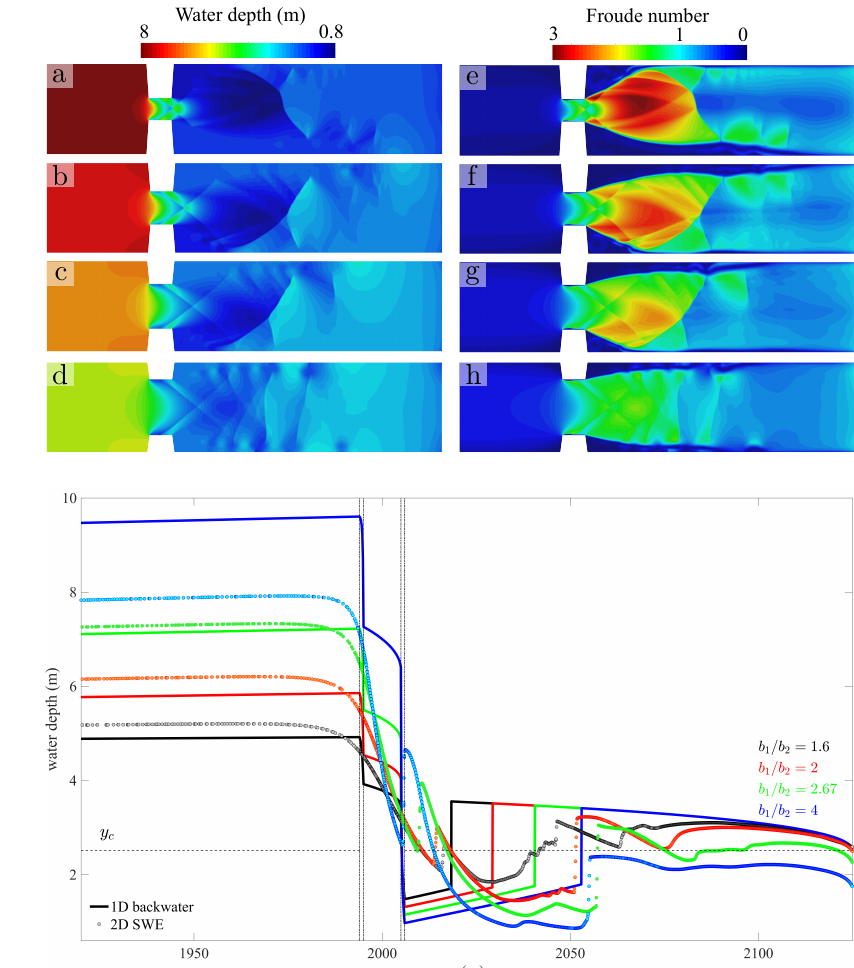
Figure 19. Flow patterns at abrupt contractions and large width ratios, b 1 / b 2 . We show maps of water depth (panels a – d ) and Froude number (panels e – h ) for different width ratios, leading to increasing effective Froude numbers in the supercritical flow region. We increase the Froude number downstream of the contraction by keeping the basic flow conditions of Figures 3, 16 and 17, in particular b 1 = 40 m, and considering an abrupt contraction, L e = 1 m, while reducing the width of the narrowest segment, b 2 . The width ratios are b 1 / b 2 = 4 (panels a and e ), 2.67 (panels b and f ), 2 (panels c and g ), and 1.6 (panels d and h ). We compare the 1D and 2D predictions of the water surface profile (panel i ). We use dots for profiles along the channel axis in 2D simulations, and solid lines for the 1D theory. Line colors correspond to the different width